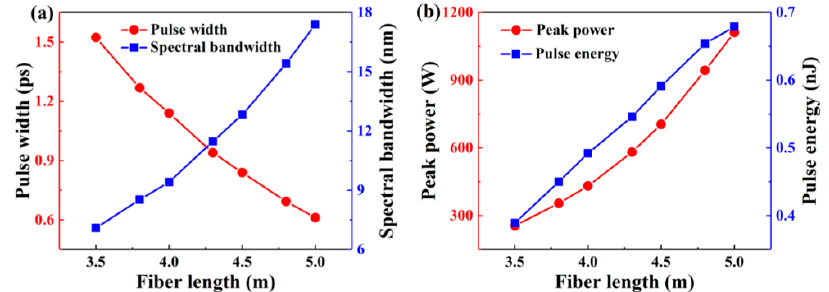
Figure 4. Output pulse characteristics of the passively mode-locked Er 3+ -doped fluoride fiber laser. ( a ) Pulse width and 3 dB spectral bandwidth and ( b ) peak power and pulse energy as a function of fiber length.